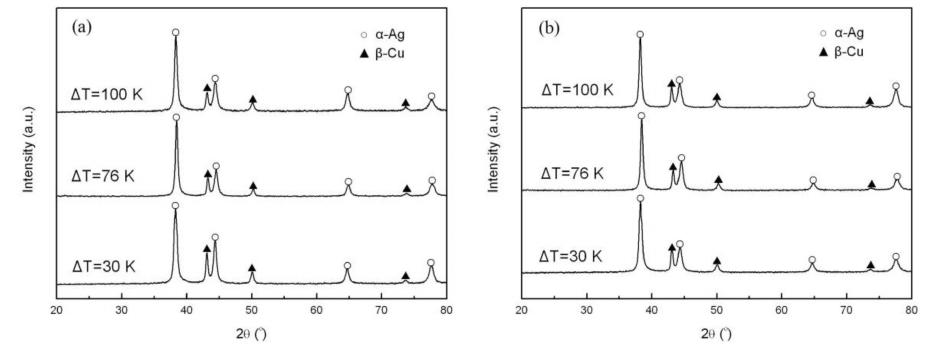
Figure 3. XRD patterns of the alloys Sb-containing solidified at different undercoolings, ( a ) (Ag-28.1Cu)-0.5Sb, and ( b )